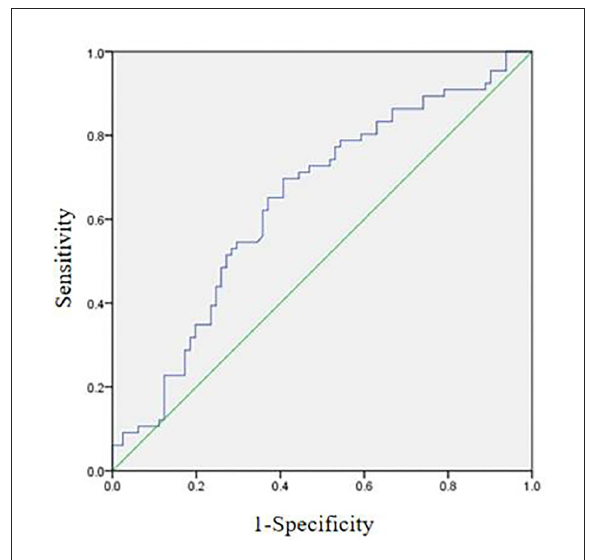
FIGURE2 Receiver operating characteristic curve analysis of patients with CI.